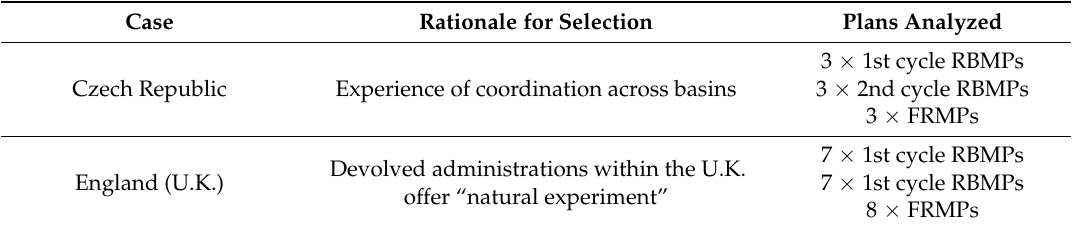
Table A1. The set of 160 plans from 9 cases used in content analysis. The process of planning under the WFD predates that of the FD; therefore, two sets of RBMPs were available, and one set of FRMPs. Case Rationale for Selection Plans Analyzed 3 × 1st cycle RBMPs Czech Republic Experience of coordination across basins 3 × 2nd cycle RBMPs 3 × FRMPs 7 × 1st cycle RBMPs Devolved administrations within the U.K. England (U.K.) 7 × 1st cycle RBMPs offer “natural experiment” 8 ×